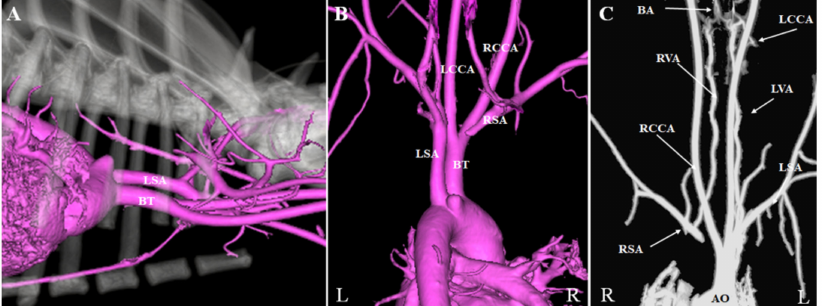
Figure 4. Three-dimensional reconstruction and multiplanar reconstruction of computed tomo- graphic angiography performed after surgery. ( A ) Right to left view. ( B ) Dorsoventral projection views. ( C ) Multiplanar reconstruction of the coronal image (bone deleted). The ligated abnormal right subclavian artery was not enhanced. Circulation of the right forelimb was supplied via the vertebral artery. The right and left vertebral arteries merged to form the basilar artery at the level of the atlas. Abnormal expansion of the ventral spinal artery was not observed. AO: aorta; BA: basilar artery; BT: brachiocephalic trunk; L: left; LCCA: left common carotid artery; LSA: left subclavian artery; LVA: left vertebral artery; R: right; RCCA: right common carotid artery; RSA right subclavian artery; RVA: right vertebral